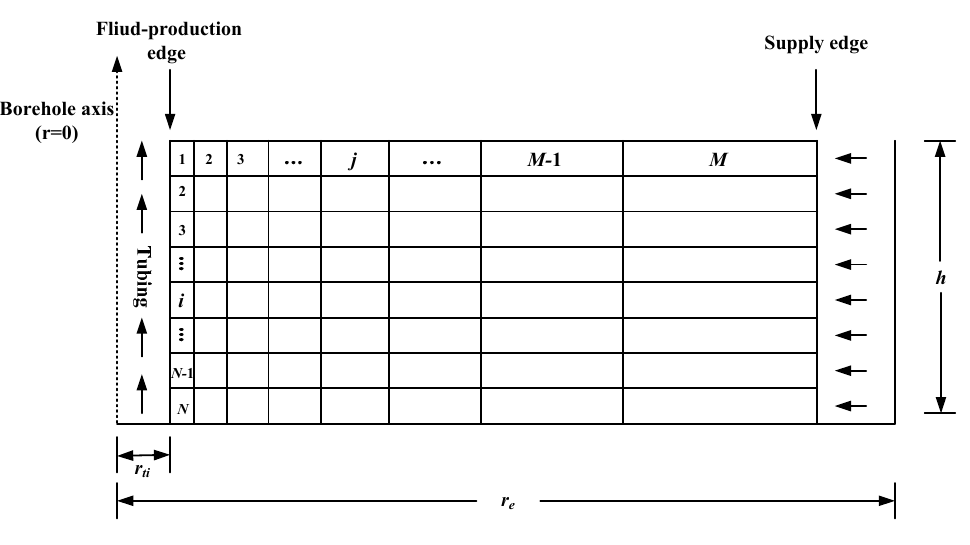
Figure 5. Schematic of the grid model for the pay zone.